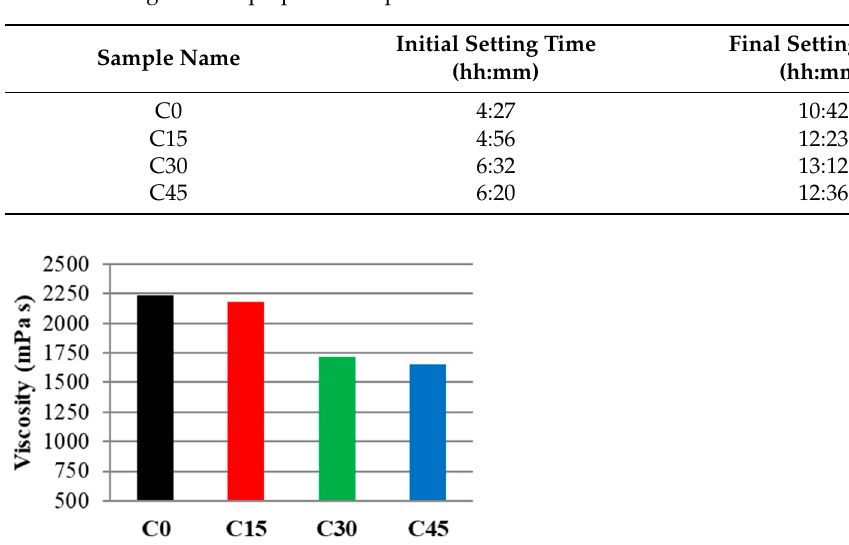
Table 3. Setting time for prepared samples.